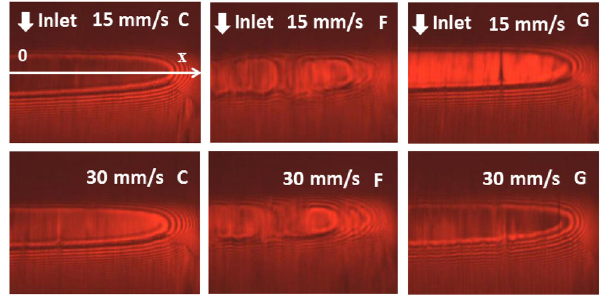
Fig. 13 Interference images of three types of grease at different speeds ( p max =0.58 GPa, straight line profile).